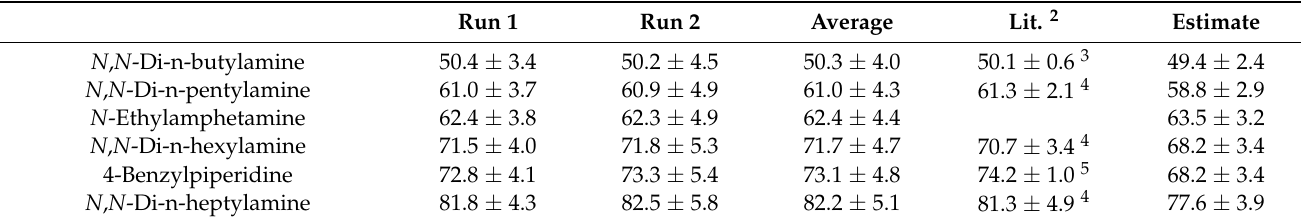
Table 5. Summary: Vaporization Enthalpy (kJ · mol − 1 ) at T = 298.15 K 1 .